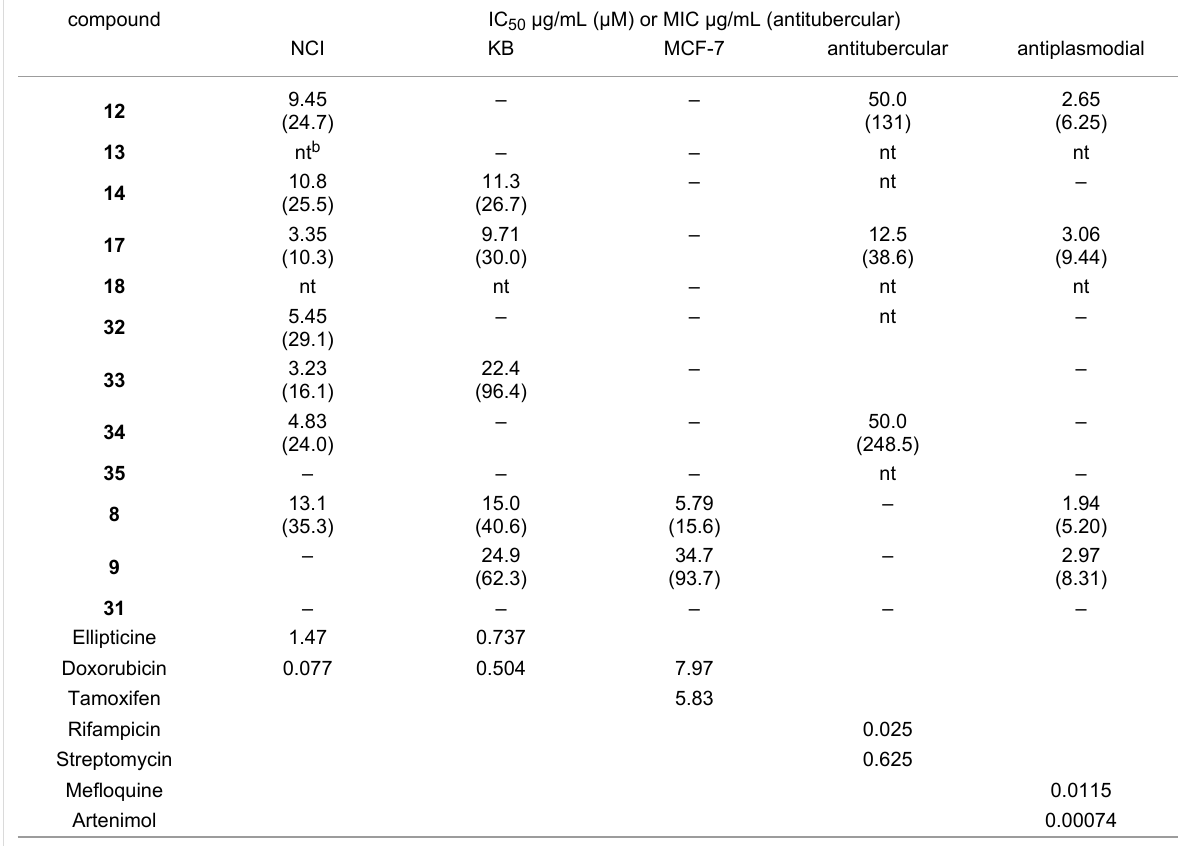
Table 2: In vitro antiplasmodial, anticancer, and antitubercular activity of compounds 12 – 14 , 17 , 18 , 32–35 , 8 , 9 , and 31 . a